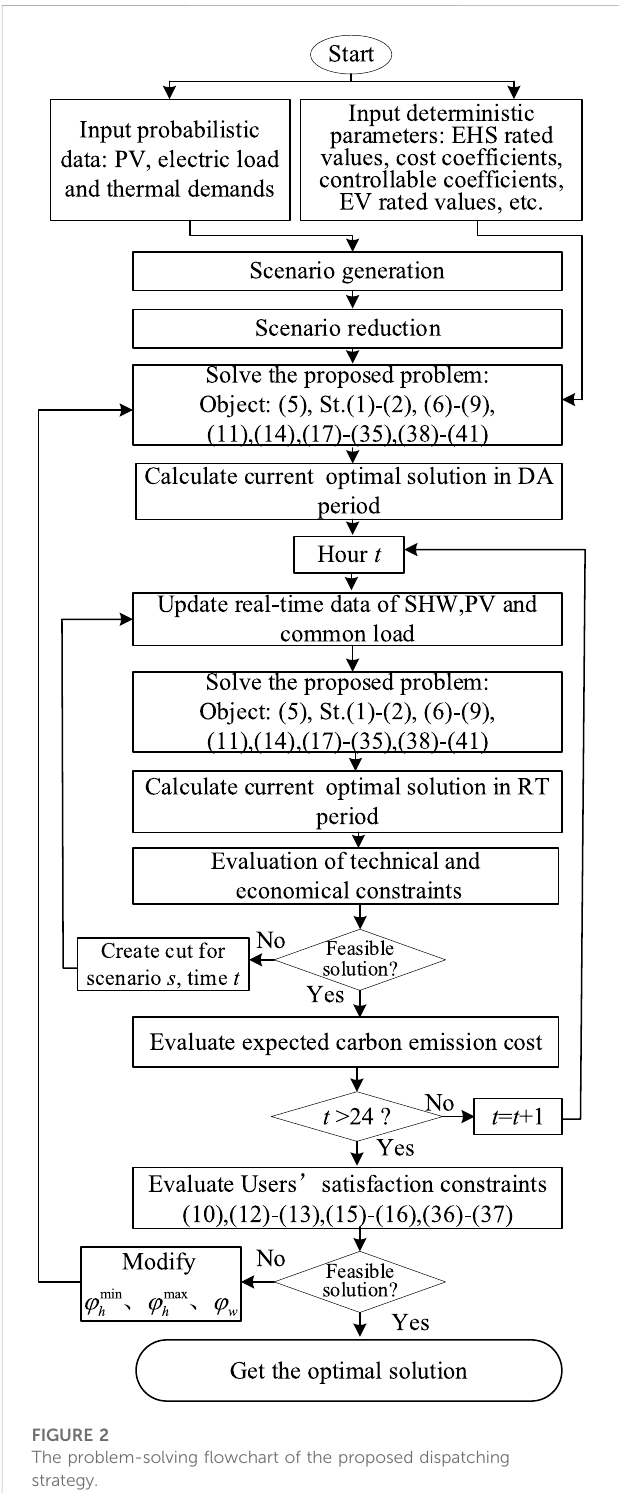
FIGURE 2 The problem-solving fl owchart of the proposed dispatching